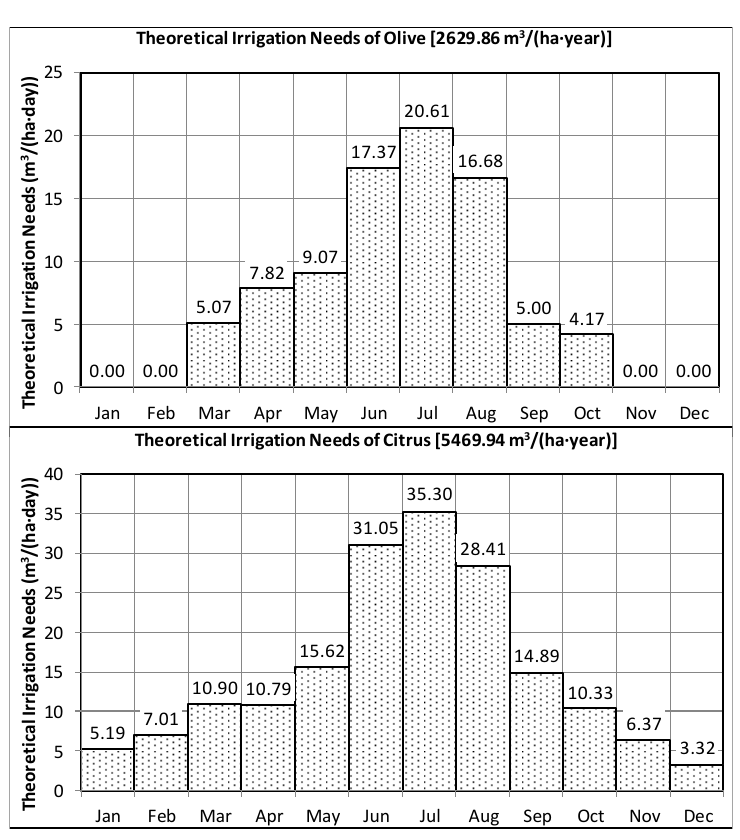
Figure 8. Pattern of irrigation needs: Top-Crop of olive. Bottom-Crop of citrus.